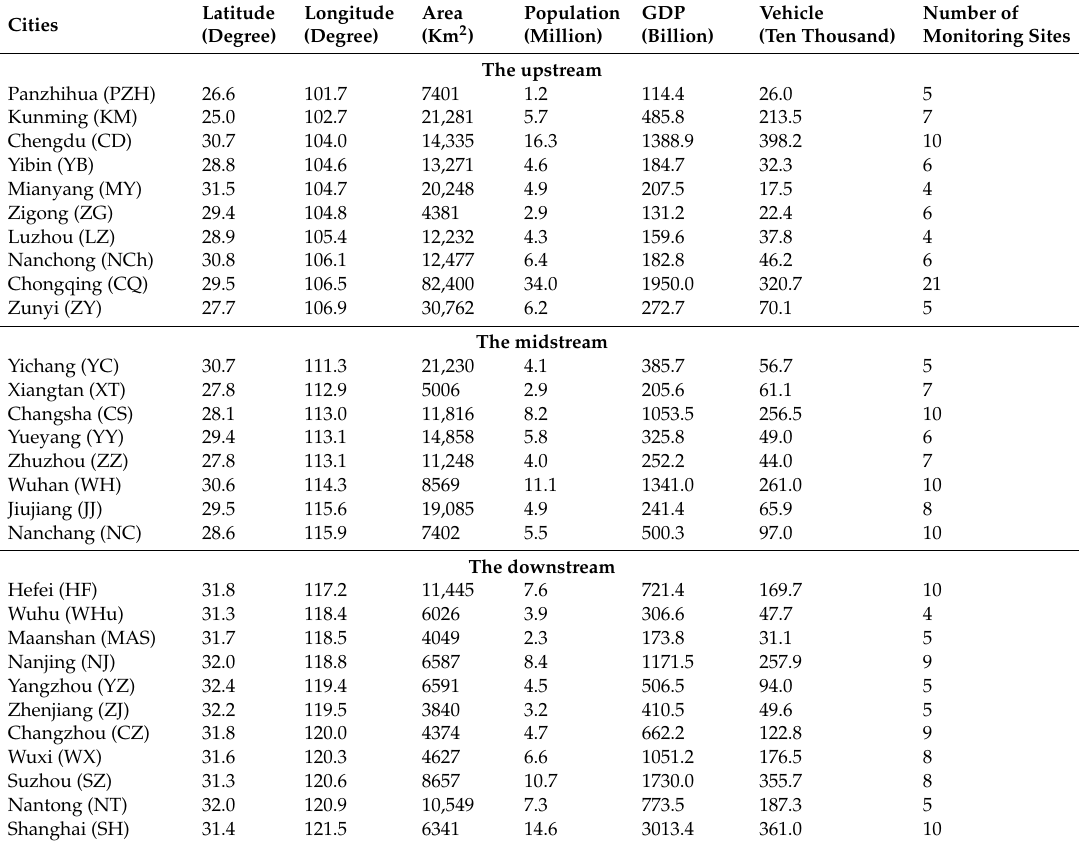
Table 1. Basic information of 29 cities over the Yangtze River Economic Belt (YREB) by the end of 2017. GDP: gross domestic product.